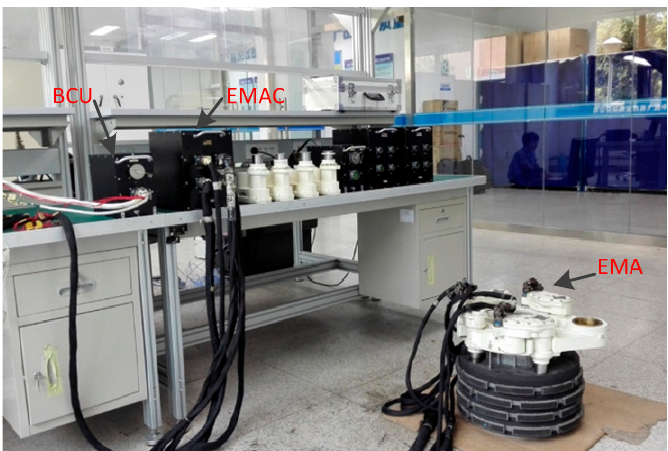
Figure 6. The EMA in HIL experimental platform.